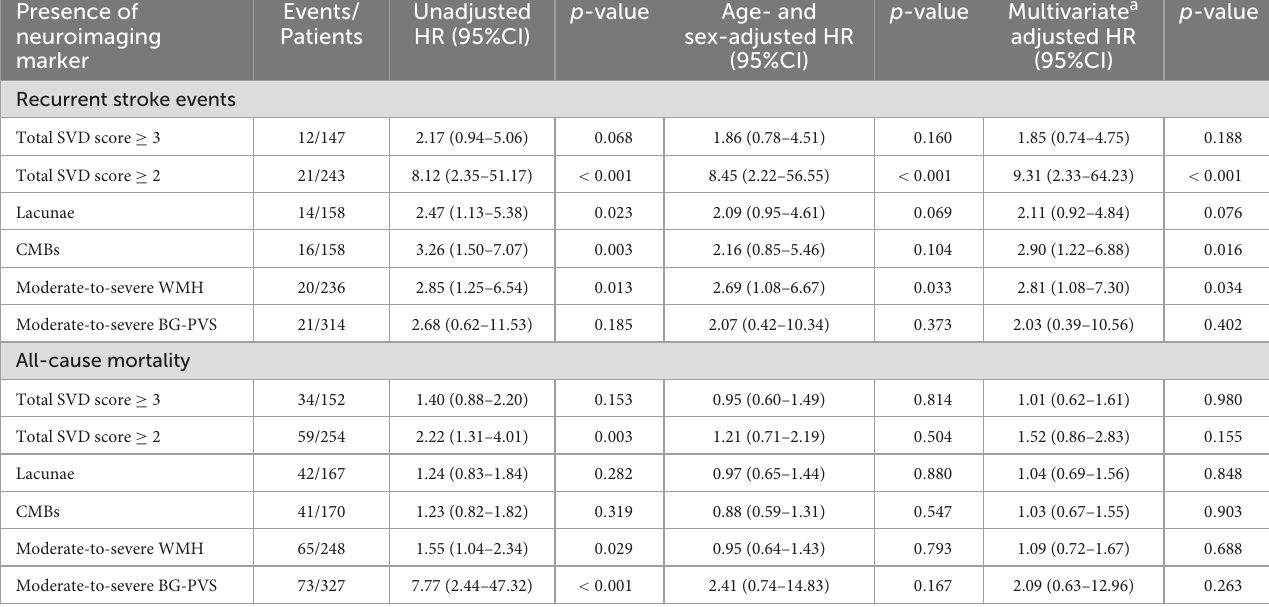
TABLE 4 Prognostic value of the presence of neuroimaging markers. Presence of